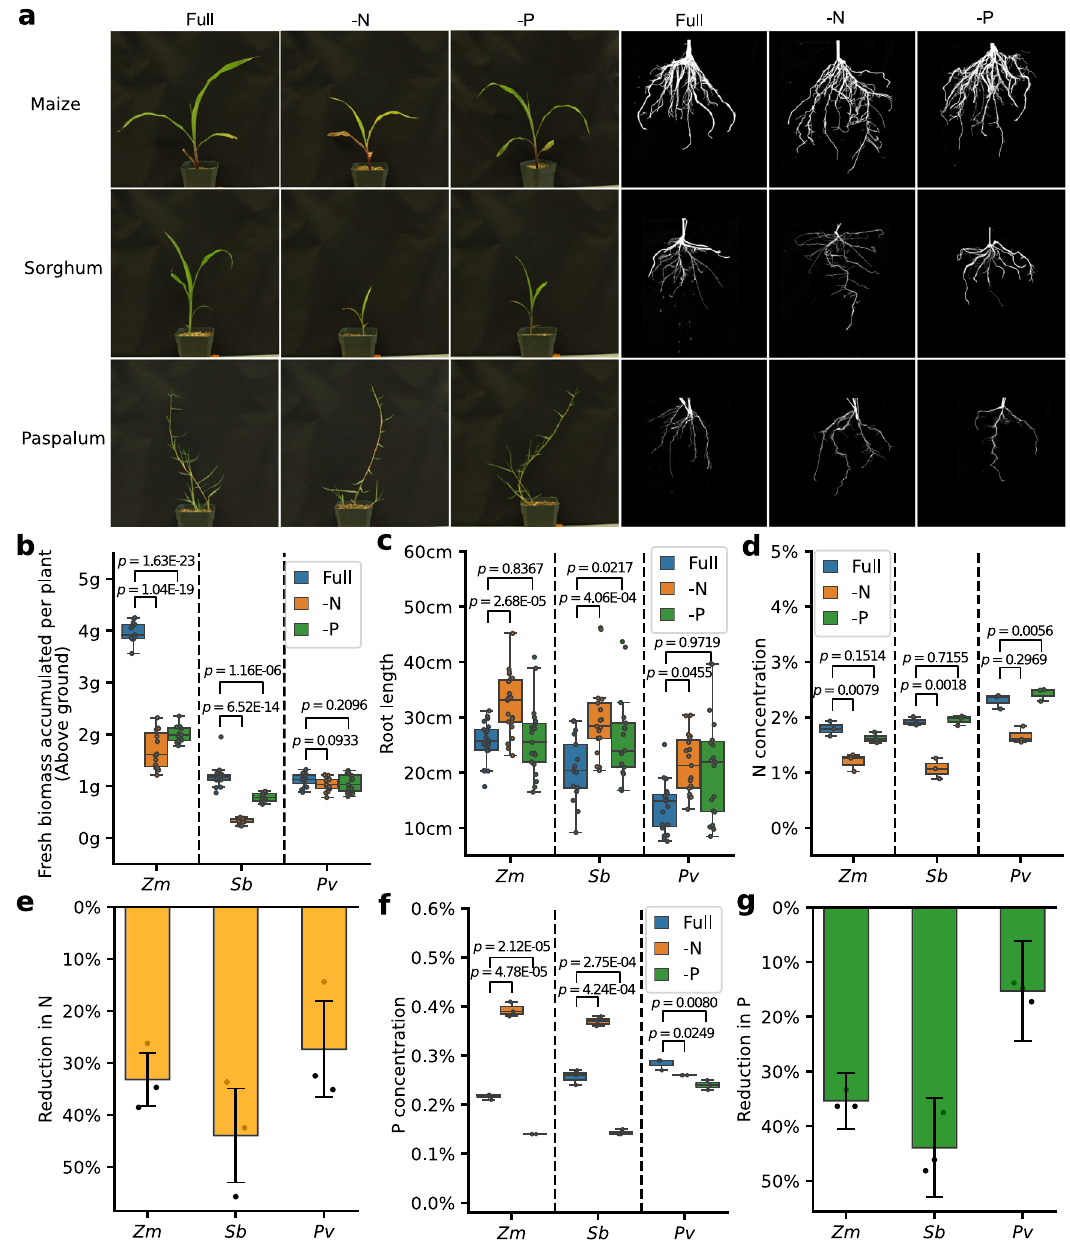
Fig. 2 | Responses of three studied species to nutrient-de fi cit stress. de fi cit (-N), or phosphorus-de fi cit conditions (-P). b Fresh biomass accumulated in d , e Abundance( d )andreduction( e )ofNasaproportionoftotaldrybiomassinthe shoots of maize, sorghum seedlings, and paspalum ramets at 21 dap. Error bars in